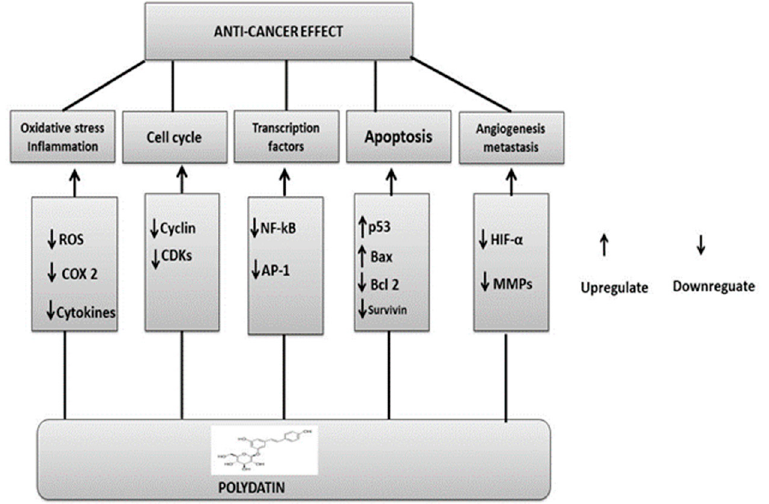
Figure 8. Polydatin anticancer mechanisms: upregulation or downregulation of various pathways.